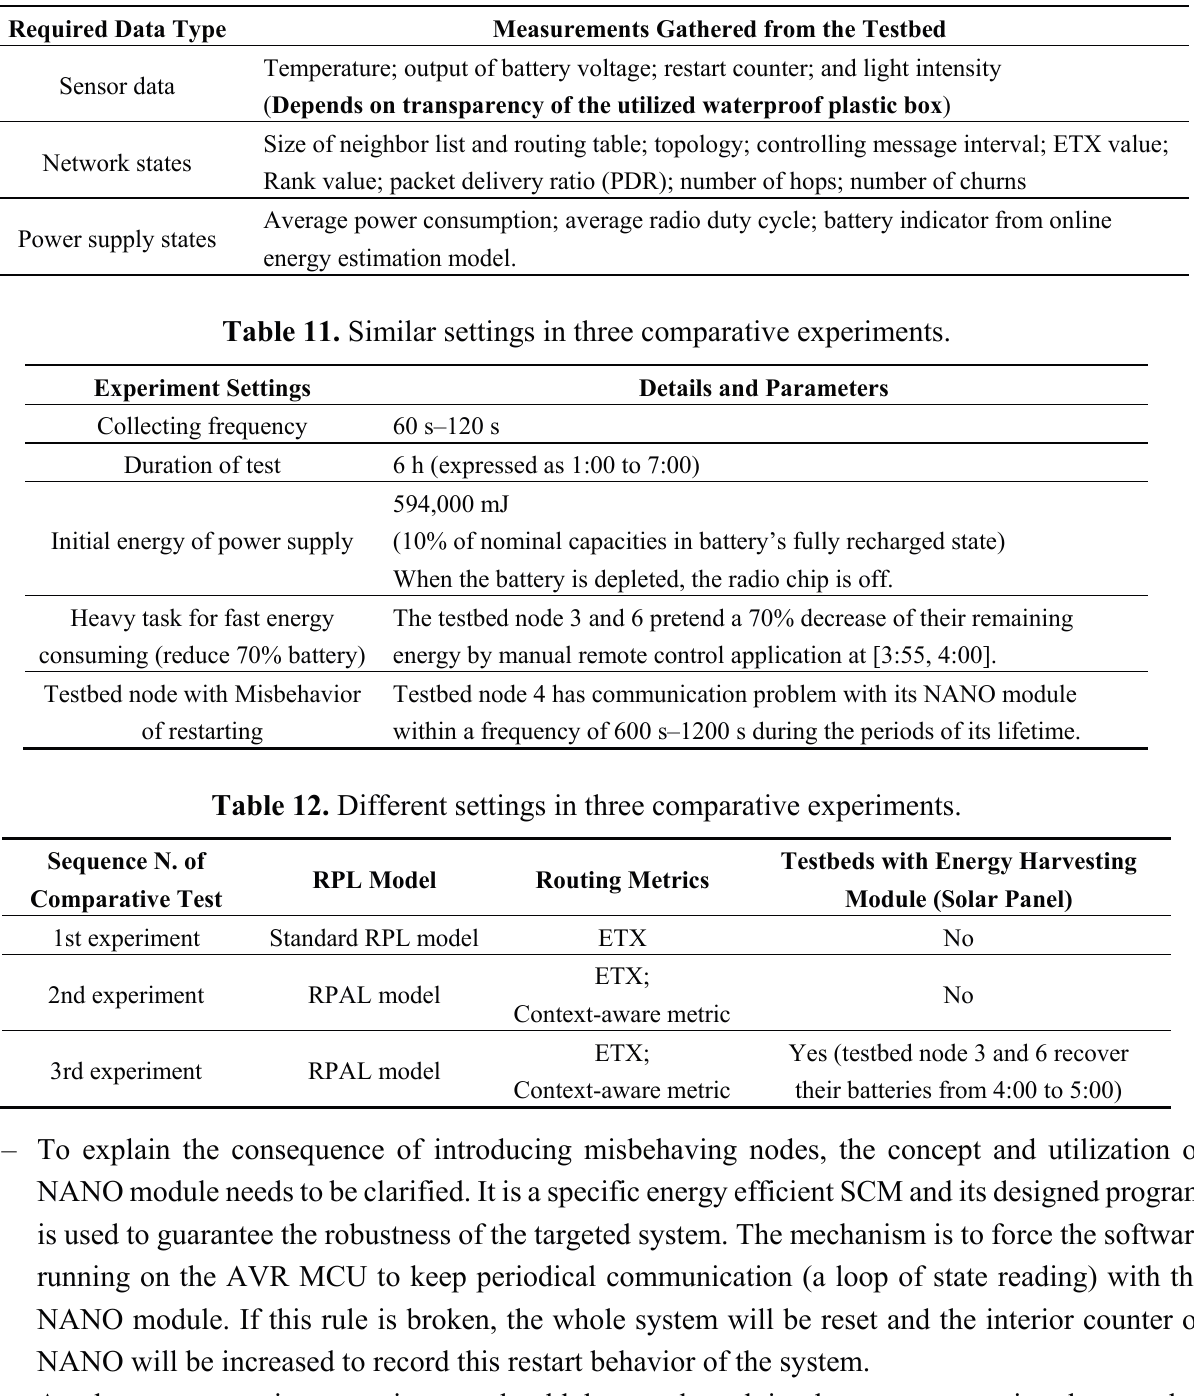
Table 10. Three main types of required measurements for statistical analysis.